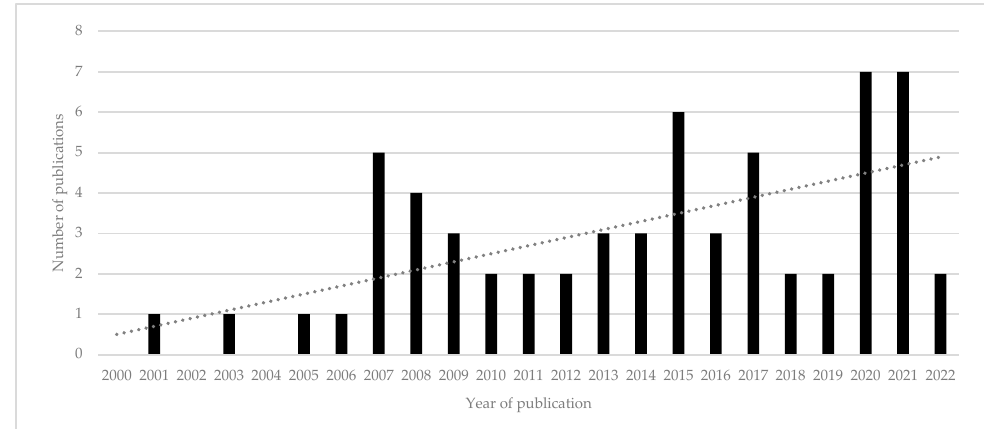
Figure 1. Number of publications per year (2000–2022) .